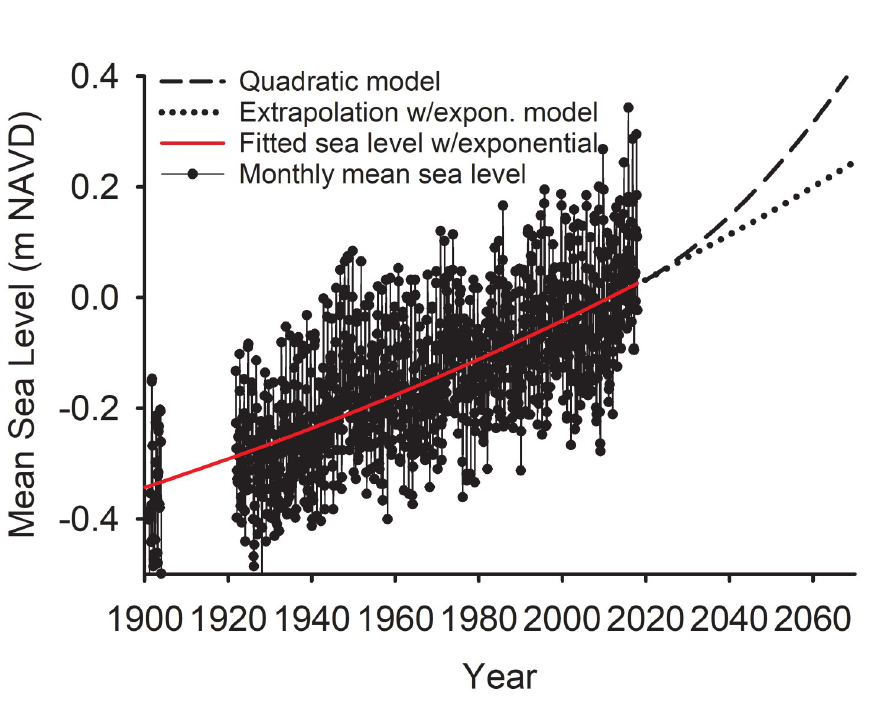
Fig 1. Monthly mean sea level. Observed mean monthly sea level in Charleston Harbor and the fitted exponential (Eq 1) to year 2018 (minus the seasonal and decadal harmonics: MSL (t) = (MSL (0) +1) e ( r t) -1, RMSE = 0.1 m, r 2 = 0.47). Also shown is the forecasted mean sea level to the year 2068, and a forecast of a SLR scenario (quadratic model) that assumes a 1 m rise in 100 years.